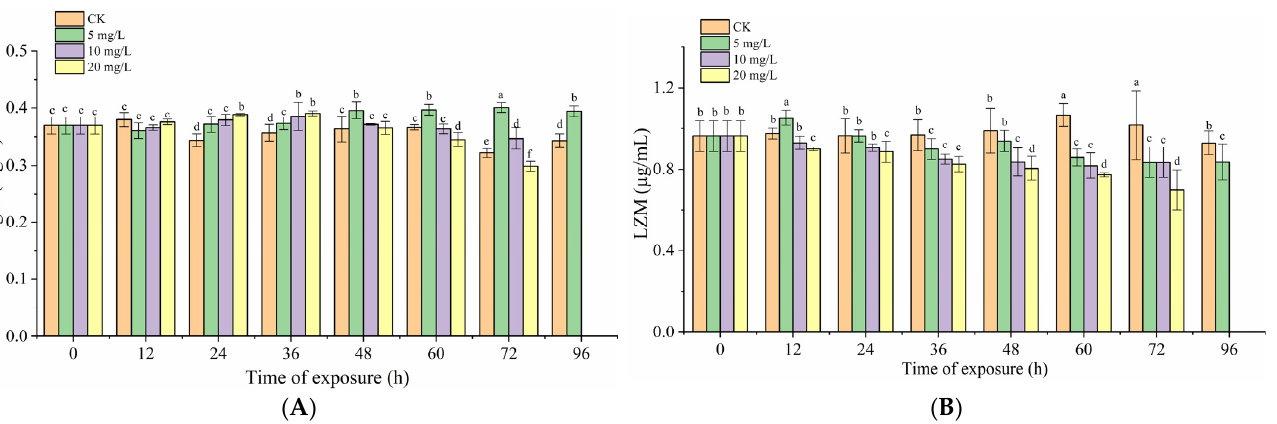
Figure 1. Changes in serum ( A ) AST, ( B ) ALT, ( C ) AKP, and ( D ) COR levels in pearl gentian grouper exposed to various nitrite concentrations over 96 h. Data are means ± SD. Different lowercase letters indicate that there are significant differences among groups ( p < 0.05).